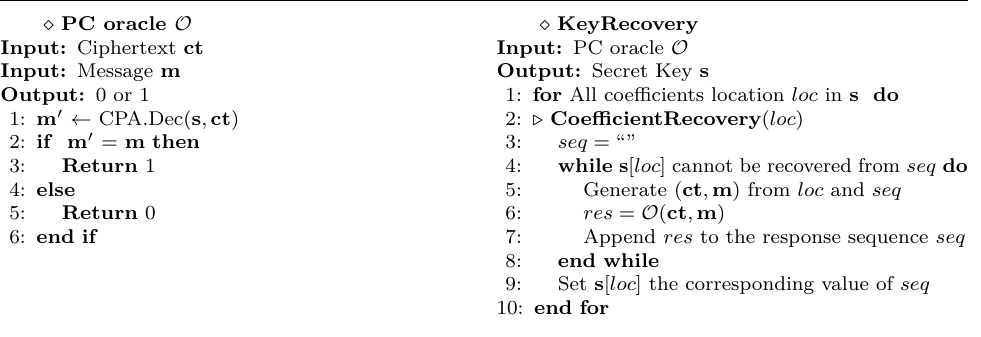
Algorithm 2 PC oracle O and the key recovery